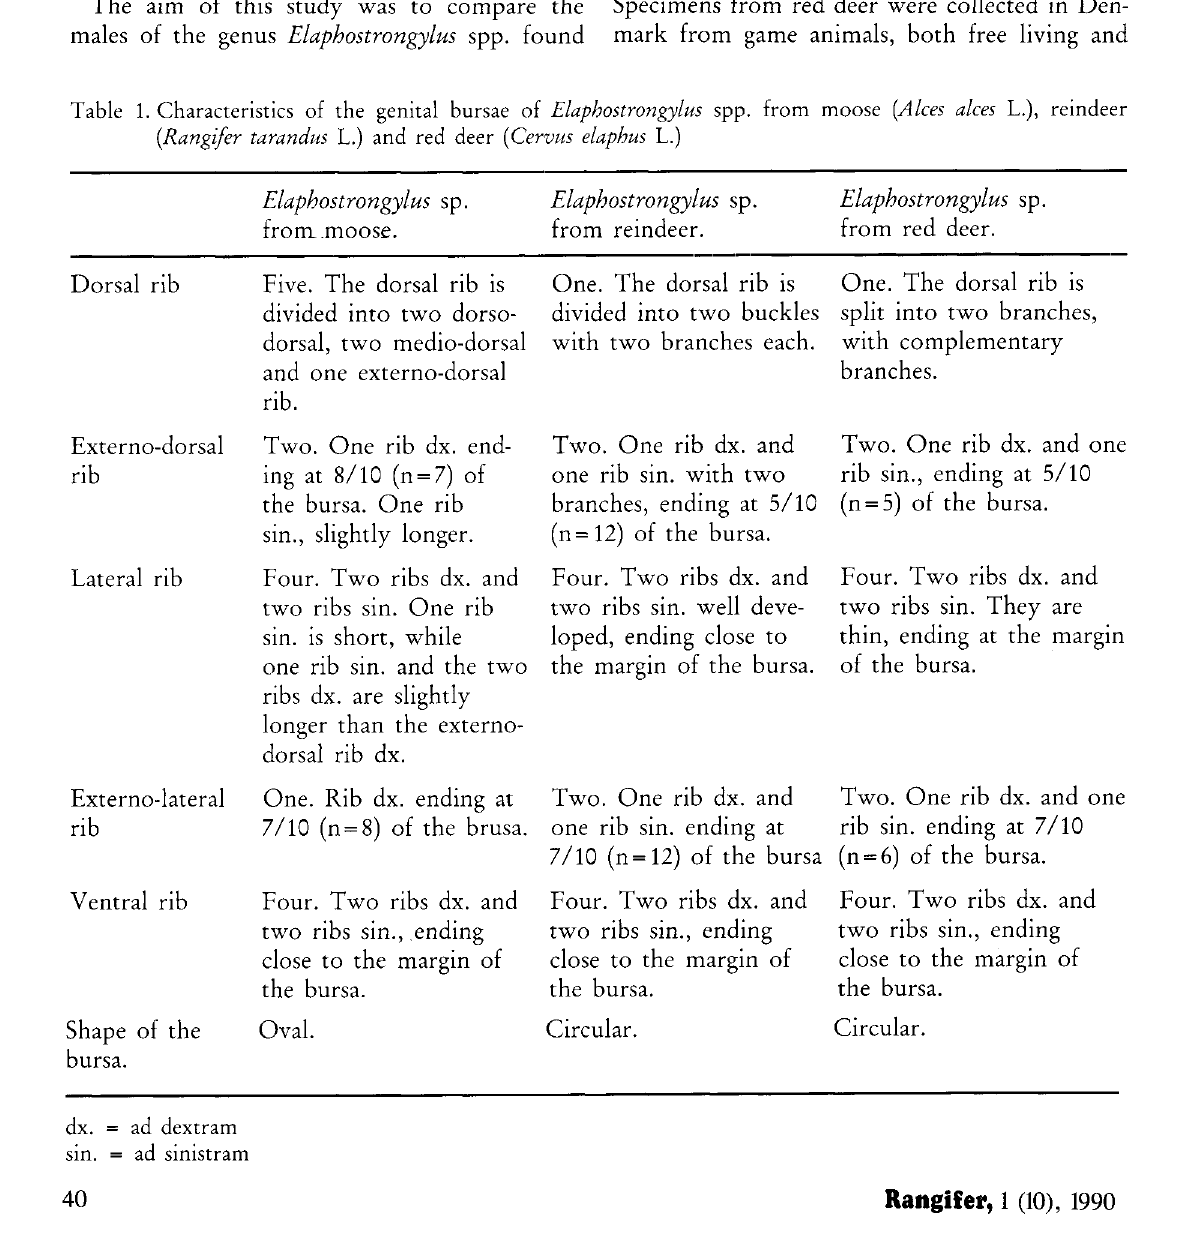
Table 1. Characteristics of the genital bursae of Elaphostrongylus spp. from moose (Alces alces L.), reindeer (Rangifer tarandus L.) and red deer (Cervus elaphus L.) Elaphostrongylus Elaphostrongylus sp. from moose.